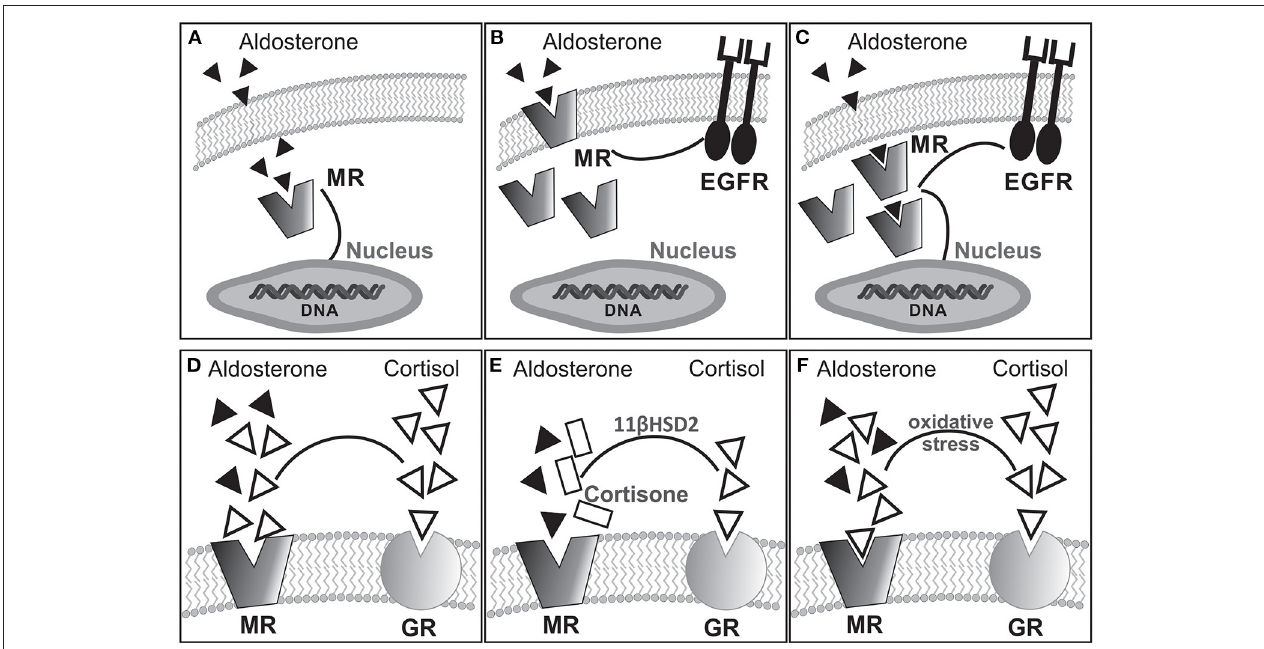
FIGURE 1 | Hypothetical alternative pathways for MR activation-dependent effects: (A) classical cytosolic MR linked to genomic response; (B) membrane bound MR transactivating EGFR for nongenomic response coexisting with cytosolic MR; (C) cytosolic MR triggering both genomic and nongenomic responses. Experimental evidence suggests that rapid nongenomic effects would involve a subpopulation of MR located in the plasma membrane (1, 8, 9) as shown in (B) . Furthermore, as with other steroid hormone receptors, nongenomic MR signaling relies on crosstalk with other signaling cascades, among which EGFR transactivation seems to be of importance ( 4–6, 10). (D–F) Possible MR occupation by ALD or cortisol under different conditions. In the absence of 11 β HSD2 (D) , cortisol occupies but does not activate the MR. The presence of 11 β HSD2 converts cortisol into cortisone allowing ALD occupancy/activation of the MR (E) . Interestingly, pathologic oxidative stress facilitates occupancy/activation of the MR by cortisol (F)